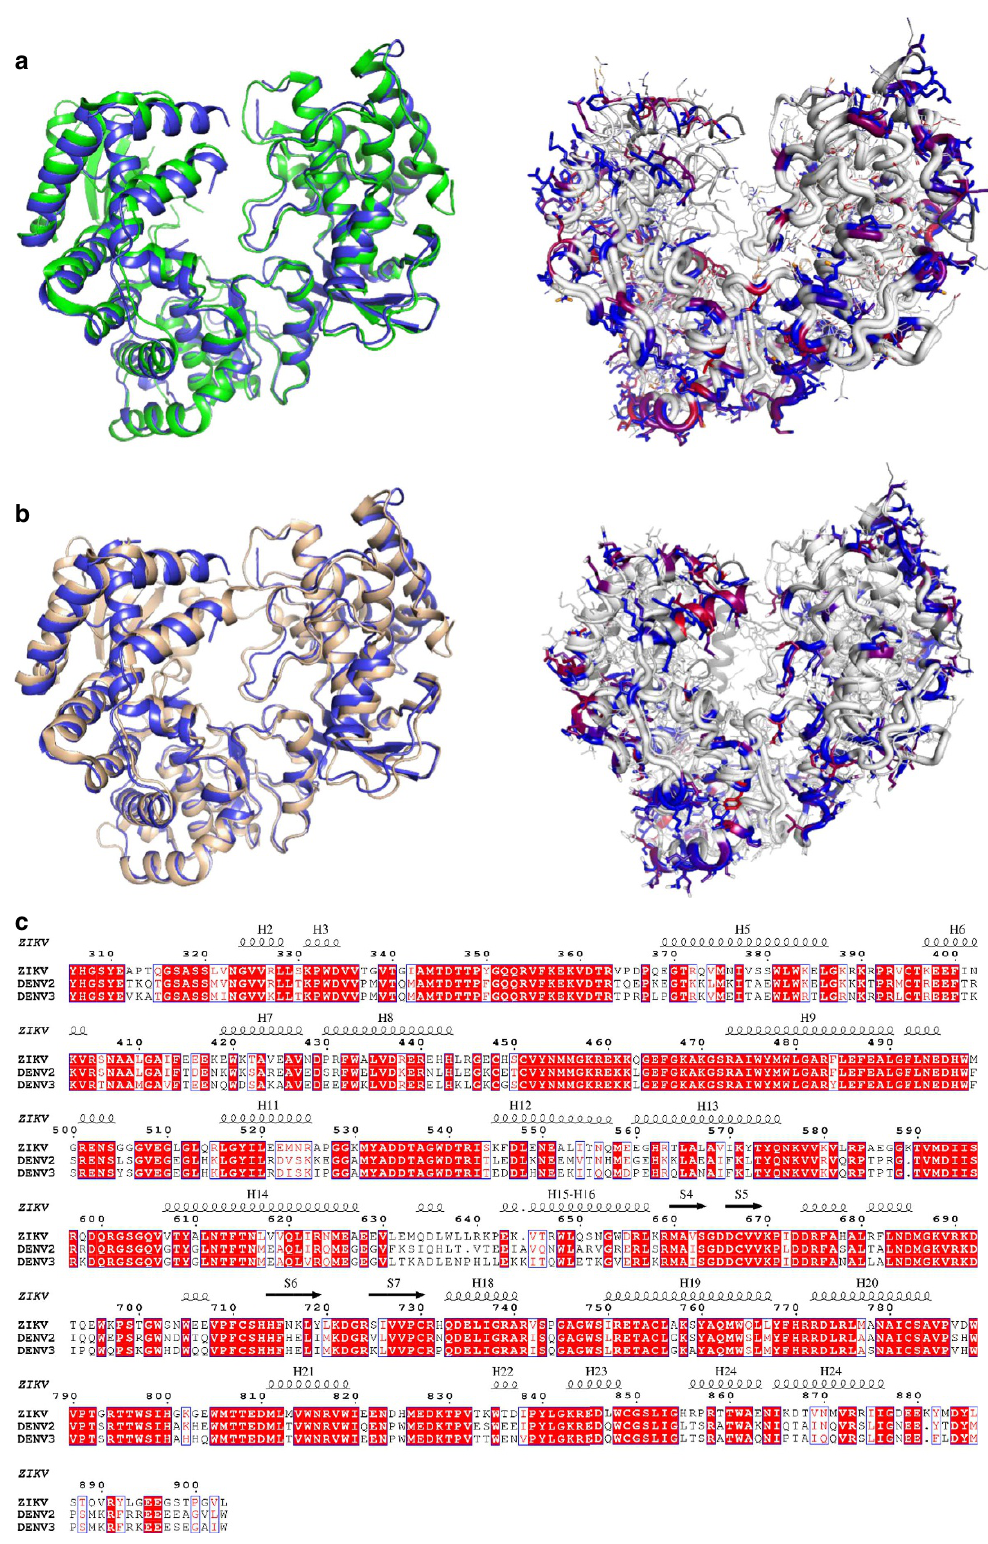
Figure 3 | Primary and tertiary structural comparison of Zika and dengue virus NS5 RdRp. ( a ) Superposition (left) and coloured differences (right) of the NS5 RdRp structures of DENV2 (green) and ZIKV (blue). ( b ) Superposition (left) and coloured differences (right) of the NS5 RdRp structures of DENV3 (wheat) and ZIKV (blue). In the right panel, mutations are coloured by percentage of difference in a blue–red scale, based on a BLOSUM90 substitution matrix. ( c ) Alignment of the NS5 RdRp sequences of ZIKV, DENV2 and DENV3, with secondary structure of ZIKV depicted at the top. Red boxes show conserved residues, while blue boxes show conserved substitutions. Helix were named with H, while strands with